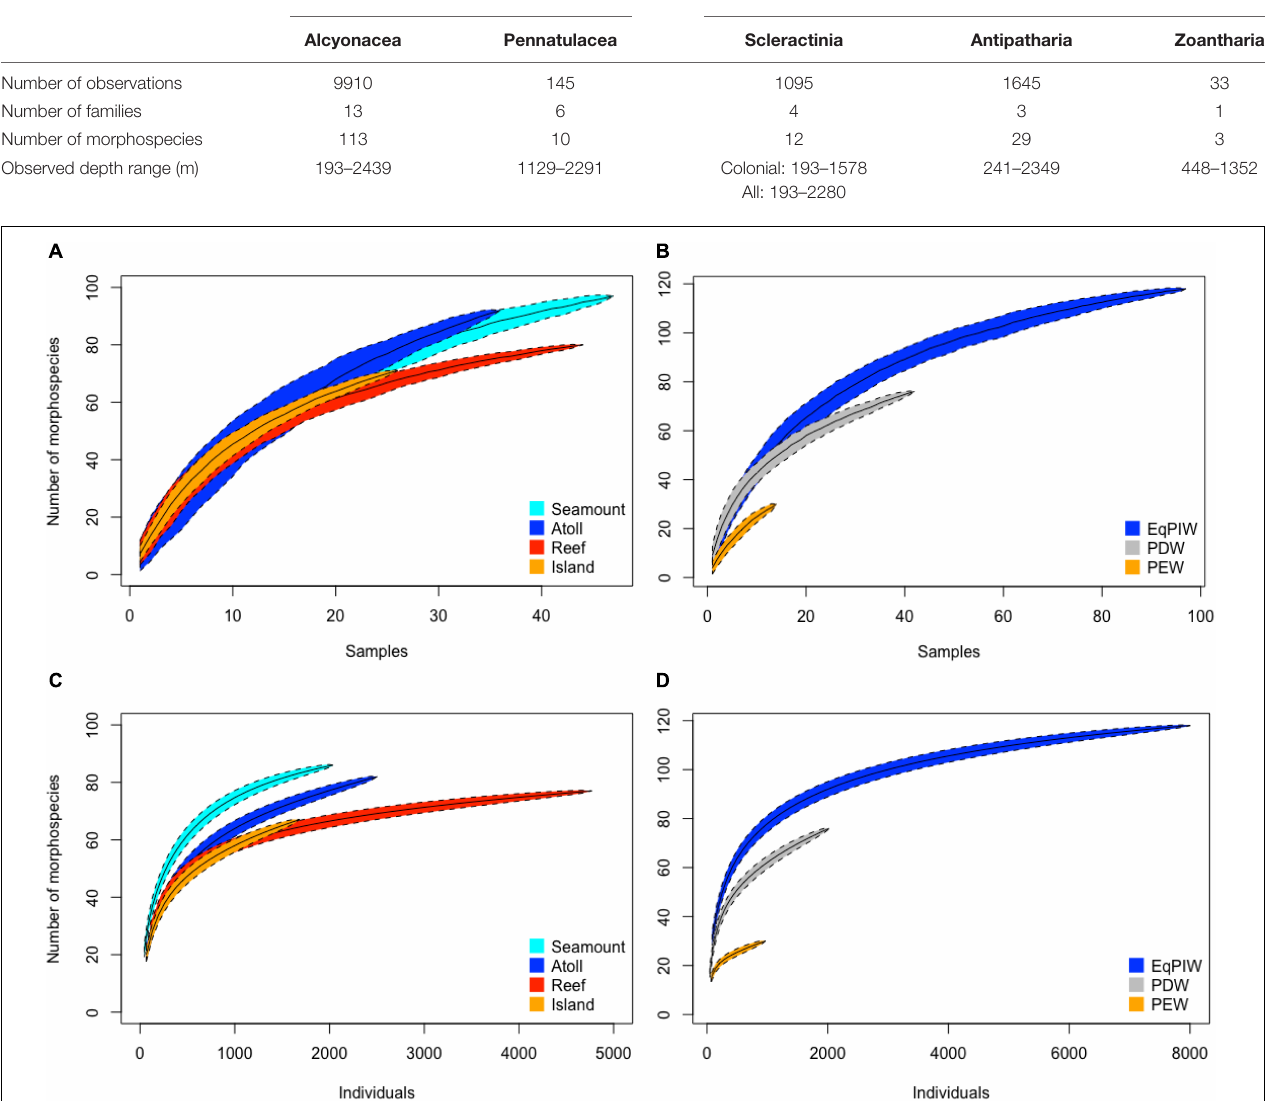
FIGURE 5 | Species accumulation and individual-based rarefaction analyses by feature type and water mass. Sample-based species accumulation curves are presented for feature types (A) and water mass (B). All depths were included for each feature type with N = 26 samples for islands, N = 36 for atolls, N = 47 for seamounts, N = 44 for reefs. For water masses, N = 14 samples were used for the PEW (197–500 m), N = 97 for EqPIW (500–1500 m), and N = 42 for PDW (1500–2197 m). Rarefaction curves are indicated for feature types (C) and water masses (D) . Curves are plotted with 95% confidence interval indicated by the colored